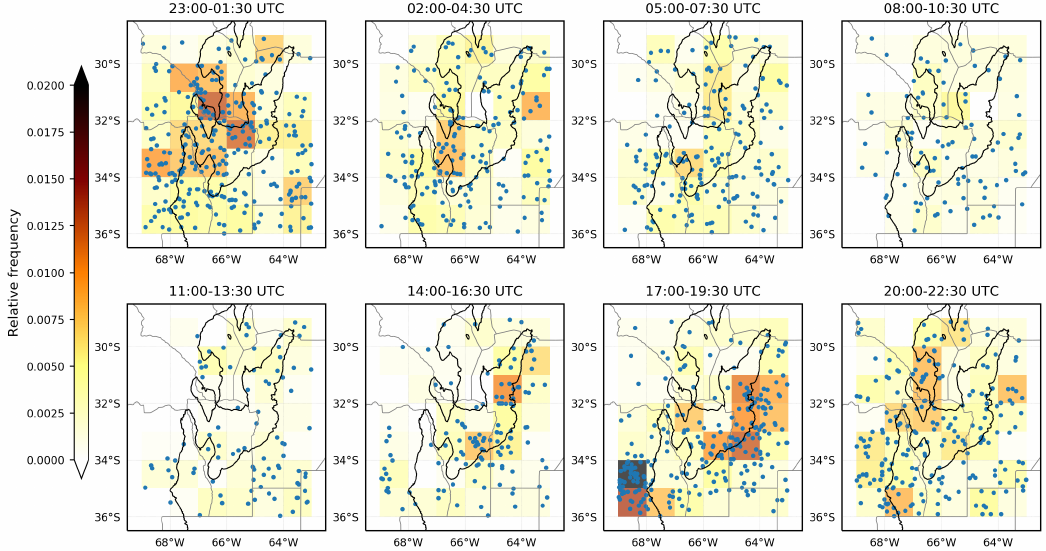
Figure 11. Diurnal cycle of relative frequency distribution in 1 ◦ × 1 ◦ boxes of ERPFs estimated convective initiations for the western central Argentina (WCA) region. Relative frequencies are plotted every 3 h starting at 23 UTC from left to right, top to bottom. TRMM sampling bias is corrected by dividing each bin by TRMM 3A25 total pixel number. The dots indicate estimated parallax-corrected CI locations. CI sample size: